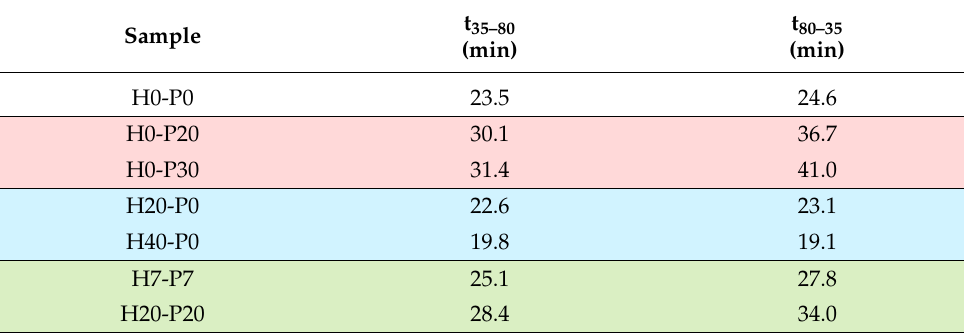
Table 4. Results of thermal profiling tests on the prepared foams.